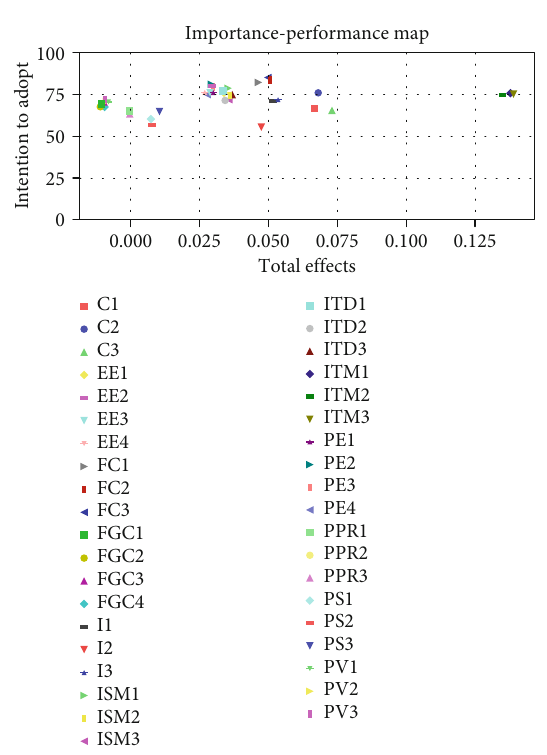
Figure 7: Importance-performance map (intention to adopt) for each